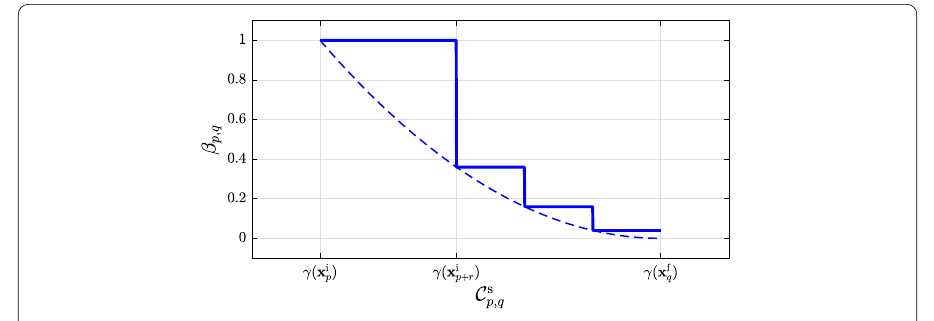
Figure 2 The weight β p , q is based on a quadratic function that decreases along the local beam path C s p , q . It is piecewise constant, largest on the first r segments in the window since they are about to be frozen (see Algorithm 1), and takes different values over the remaining segments. The weight is identical for the local secondary path C wd p , q .